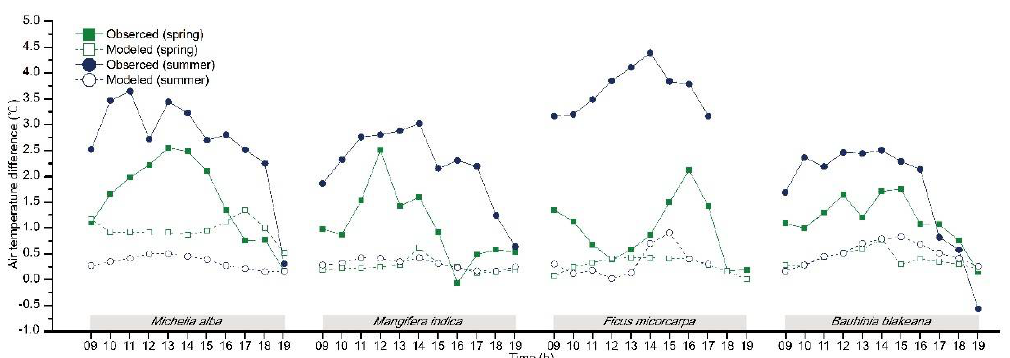
Figure 9. Comparison of modeled and observed air temperature differences between treeless areas and canopy shade areas.